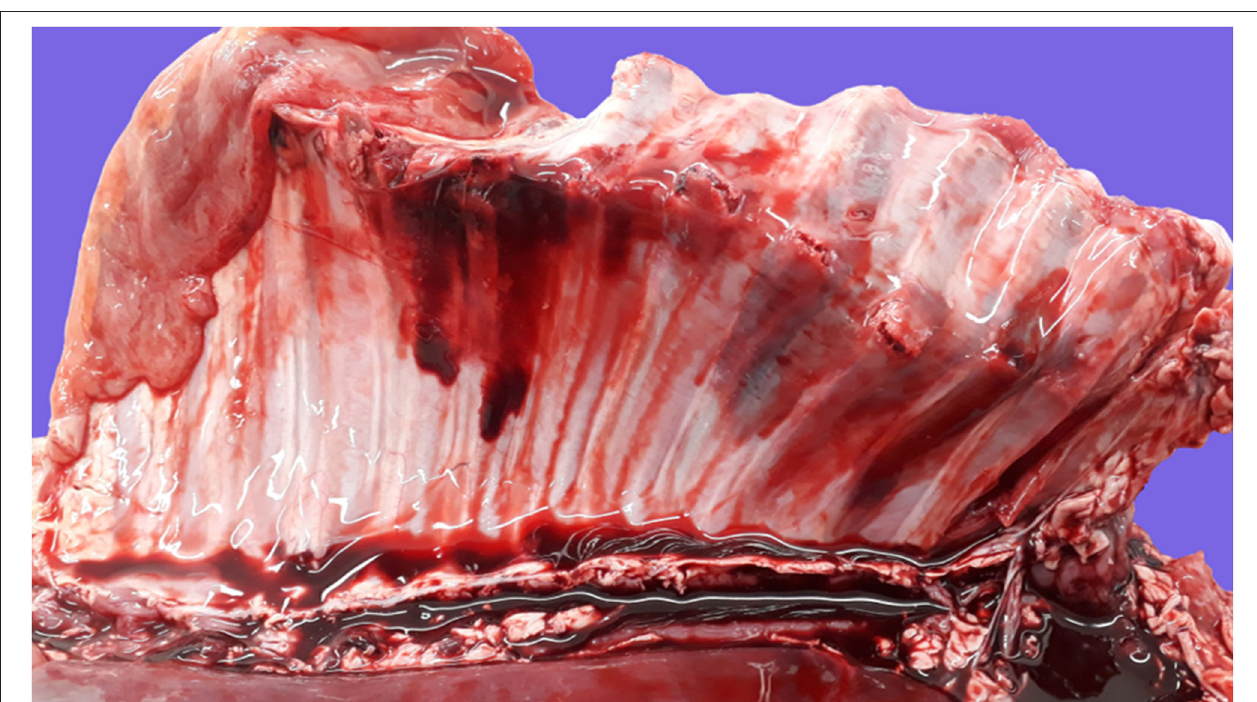
FIGURE 5 | Pathological findings in a full-term fetus with an etiologic diagnosis of dystocia. Serosal view of the right rib cage. Multiple complete displaced fractures of the body of 9 contiguous ribs with associated extensive pleural and subpleural hemorrhages and tearing of adjacent intercostal muscles. There is noncoagulated blood collected in the thoracic cavity (hemothorax), and the diaphragm and intercostal muscles of nonaffected areas are pale, consistent with anemia secondary to exsanguination. These lesions are attributable to severe acute trauma due to